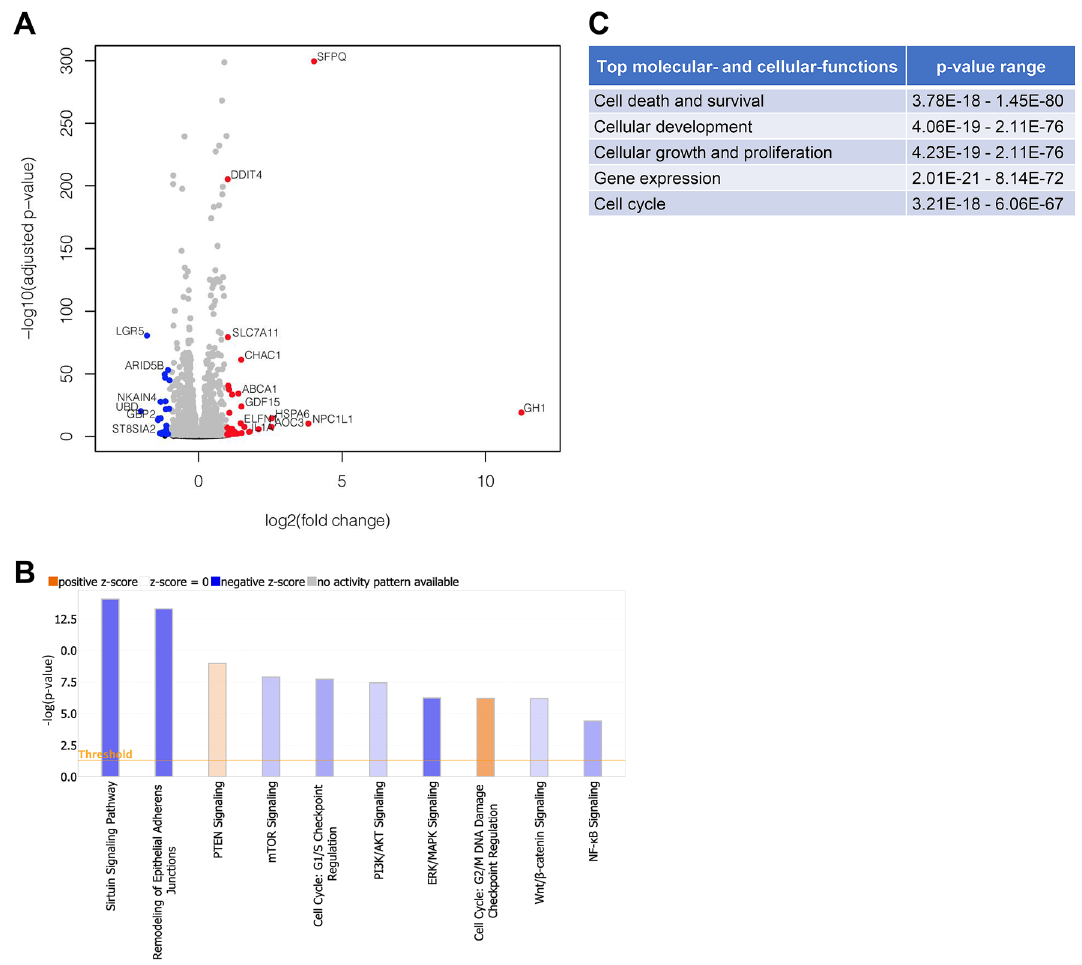
Figure 3. Impact of SFPQ on gene expression profiles and signaling pathways in CFBE cells. ( A ) A volcano plot shows the log2 fold change (x axis) plotted against − log10 (adjusted P value [Padj]) (y axis) of total RNA-sequencing (RNA-seq) data compared between SFPQ overexpressed and control CFBE41o − cells (n = 3 each group). Red circles representing significant upregulated genes, blue circles representing significant downregulated genes and grey color circles representing genes those not meeting the threshold. The statistical criterion for a gene to be considered differentially expressed was an adjusted P value < 0.05, FDR < 0.1, > ± 2 FC. ( B ) Bar graph shows the differential regulation of canonical signal transduction pathways analyzed by Ingenuity Pathway Analysis (IPA) in the SFPQ overexpressed versus control CFBE41o − cells. The bars indicate the − log (P value) of over-representation, while the orange line indicates the threshold, 2.0. The color of the bars indicates the value of the z-score, as indicated in the legends. ( C ) Top molecular and cellular functions analyzed in the SFPQ overexpressed versus control CFBE41o −